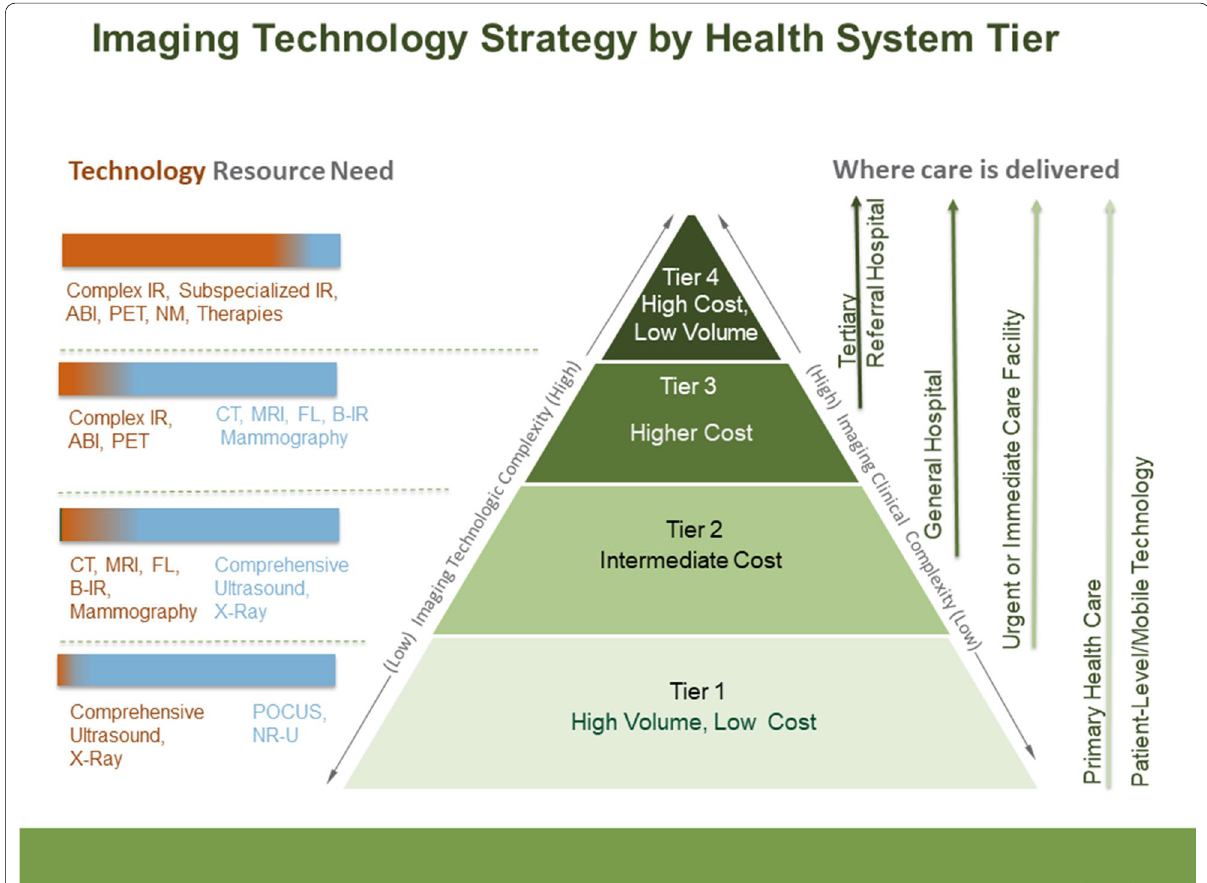
Fig. 2 Recommended imaging technology strategy by health system tier. Higher levels on the pyramid denote increasing complexity. For each tier, red indicates a requirement for higher complexity of technology while blue indicates lower complexity of technology. (POCUS Point of Care = ultrasound; NR‑U non‑radiologist ultrasound; CT computed tomography; MRI magnetic resonance imaging; FL fluoroscopy; B‑IR BASIC = = = = = Interventional Radiology; ABI advanced breast imaging; PET positron emission tomography; NM nuclear medicine; subspecialized = = = IR =